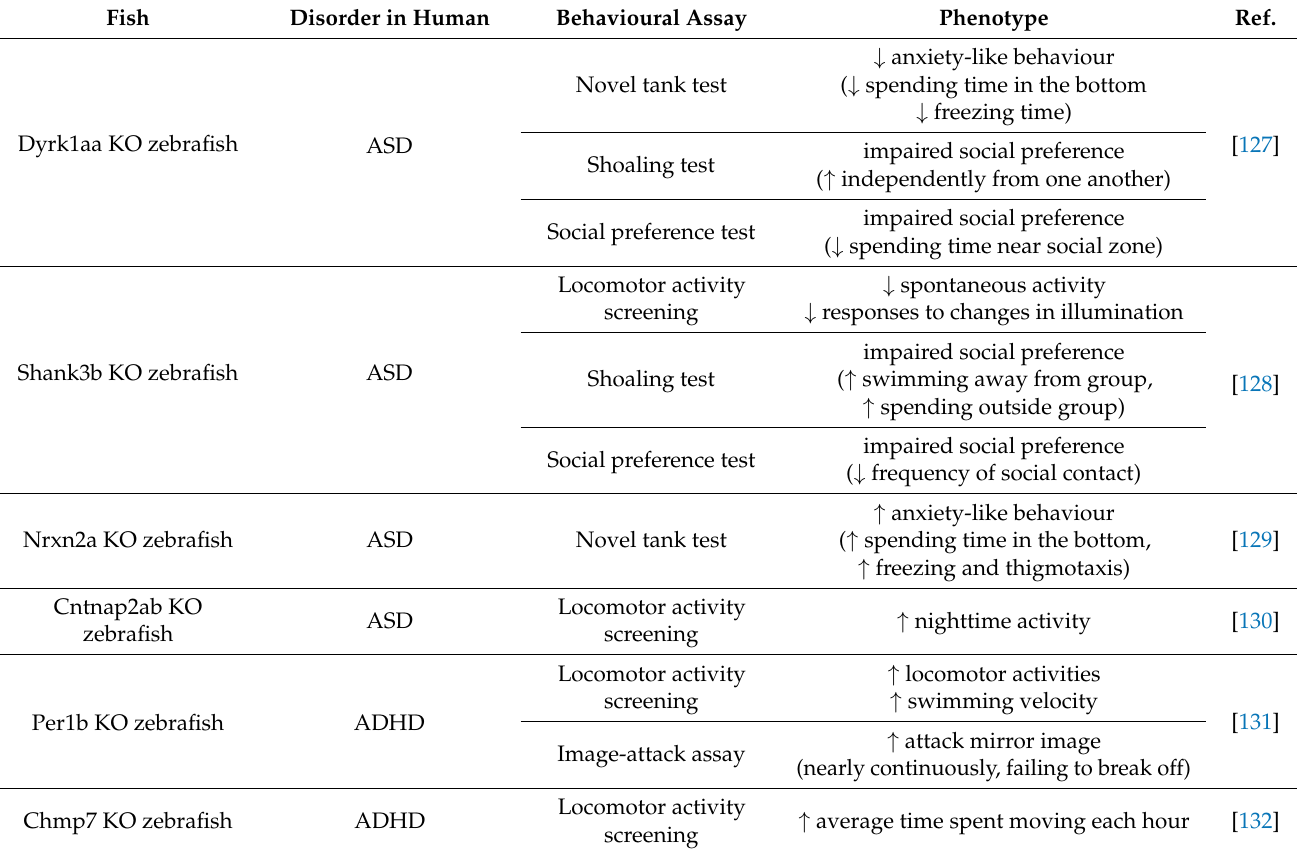
Table 2. Studies using behavioral analysis in zebrafish with gene mutations associated with neurode- velopmental